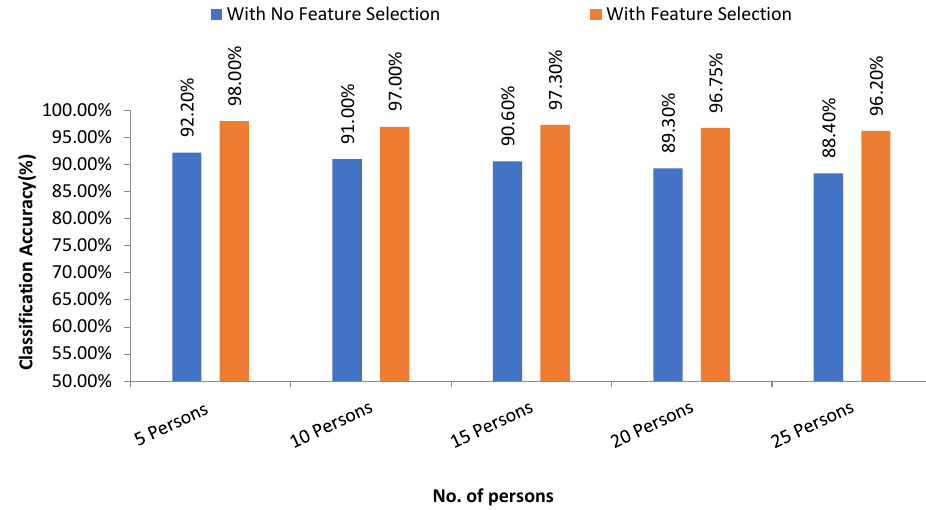
Figure 17. Classification accuracy for different persons with and without feature selection using SVM.